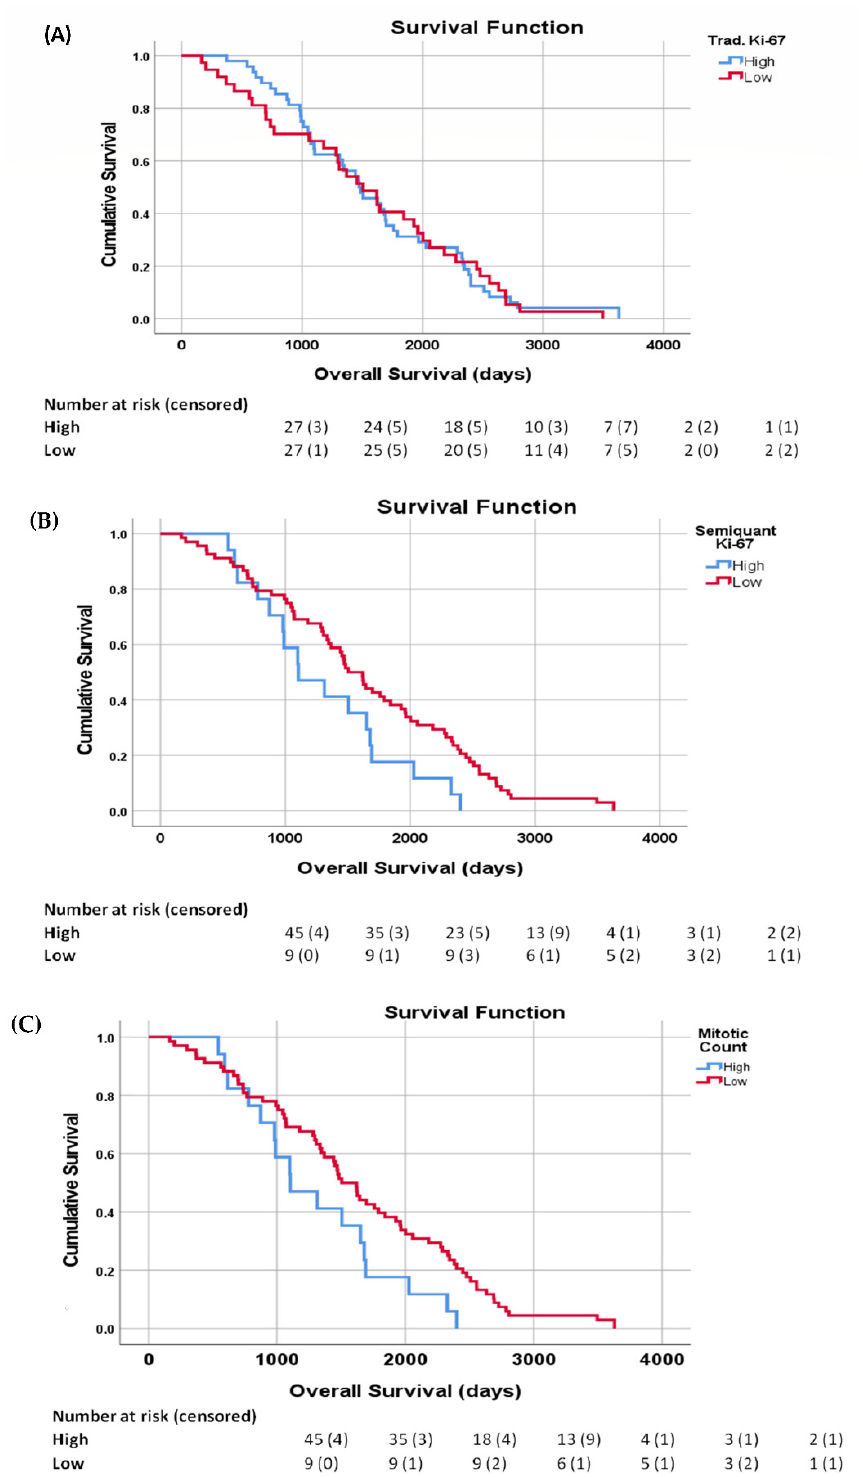
Figure 5. Kaplan–Meier of the overall survival (OS) by evaluation method. The number of events at risk and censored is included in the tables underneath. ( A ) Cumulative survival for high/low traditional Ki-67 evaluation; ( B ) cumulative survival for the new high/low semiquantal Ki-67 evaluation; ( C ) cumulative survival for high/low mitotic count.